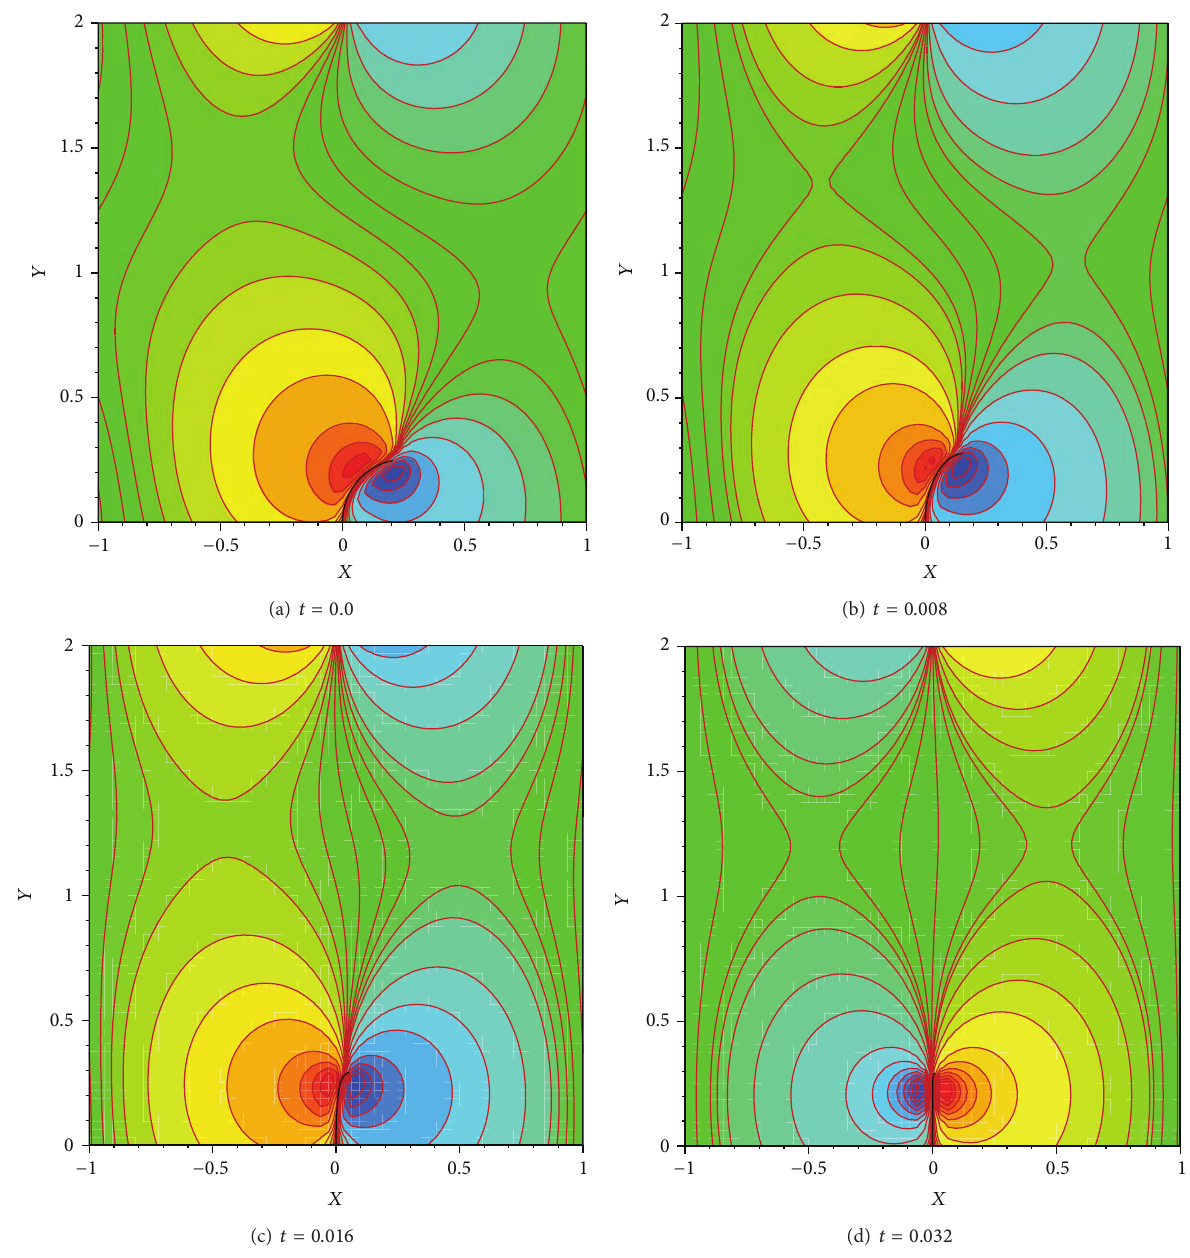
Figure 9: Pressure contours at different time steps of 0.0, 0.008, 0.016, and 0.032 corresponding to the frames (a), (b), (c), and (d),